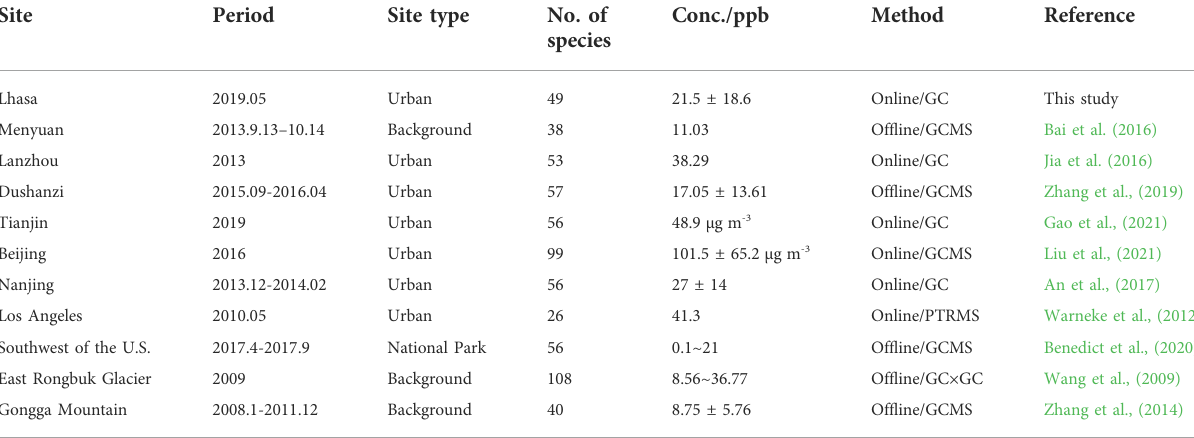
TABLE 2 Comparison of atmospheric VOCs in Lhasa with other observation